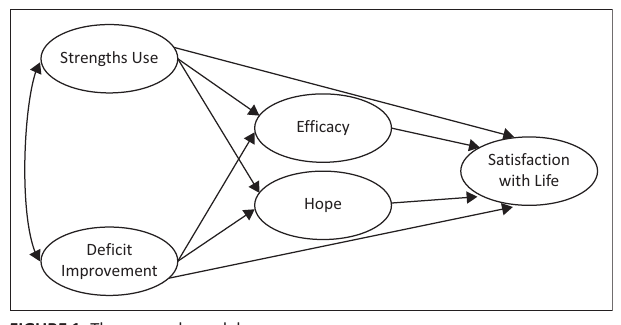
FIGURE 1: The research